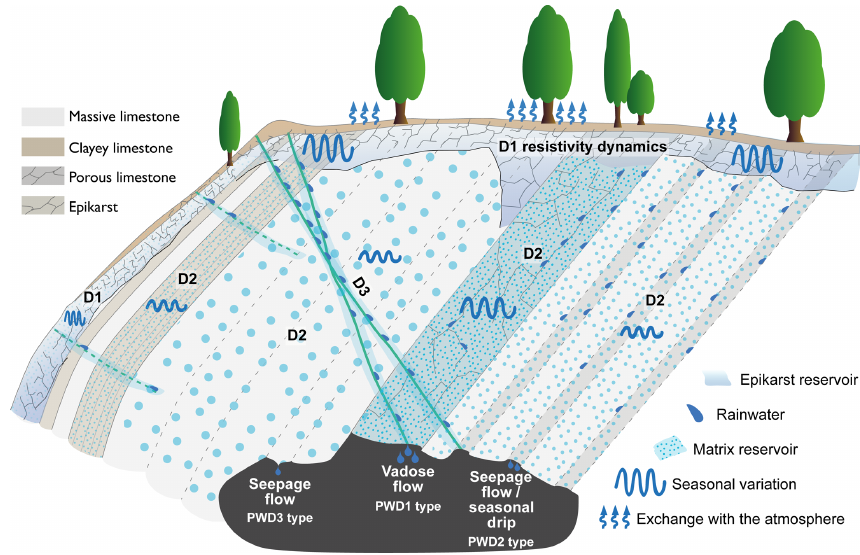
Figure 15. Schematic view of the hydrological processes occurring in the subsurface of RCL